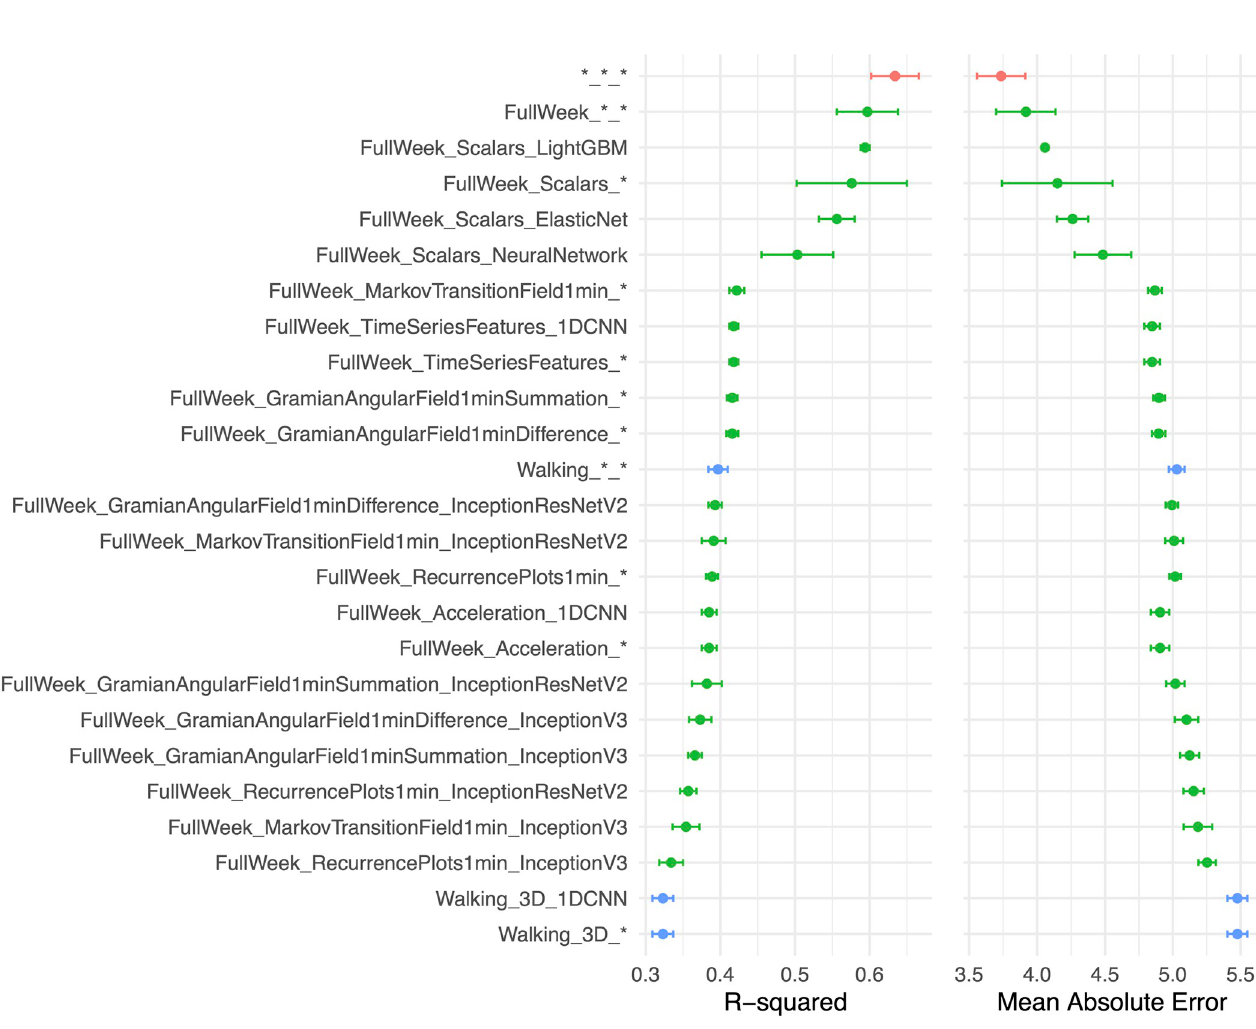
Fig 2. Chronological age prediction performance. A.) R2 (R-squared) and B.) Mean Absolute Error (MAE). Model name contain the duration (e.g., full week), data type (e.g., Scalars or Time Series), and model algorithm type (e.g., LightGBM). � represents ensemble model. Red point is the overall ensemble across all models, green points denote the measured physical activity for the full week as inputs, and blue points denote the walking or gait data as